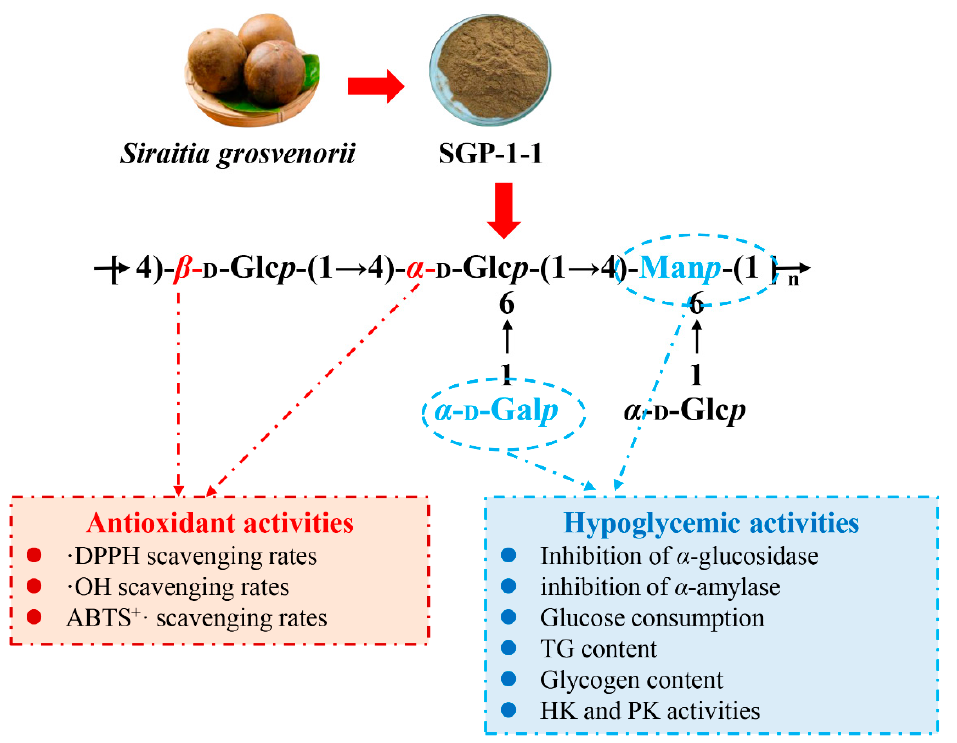
Figure 6. Relationship between structure and biological activity of SGP-1-1.